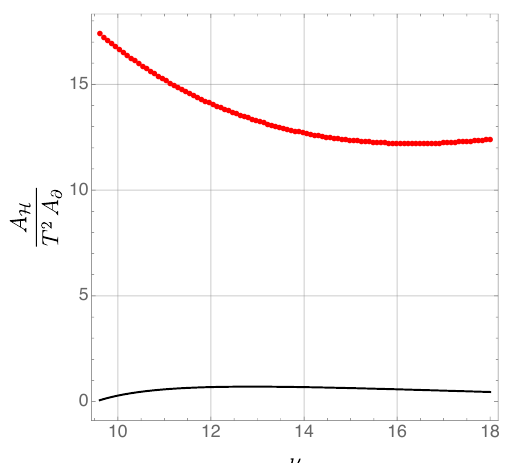
Figure 25 . The ratio A H = ( T 2 A @ ) as a function of (cid:23) for (cid:12)xed (cid:22) = 18 and using y + as in eq. (4.49) to (cid:12)x the temperature: the red disks correspond to our new numerical solutions, and the black solid line shows the corresponding quantity computed for the C-metric solutions of section 4.5. For (cid:22) = 18, the D2/D1 interface is located around (cid:23) (cid:25) 9 : 51472.